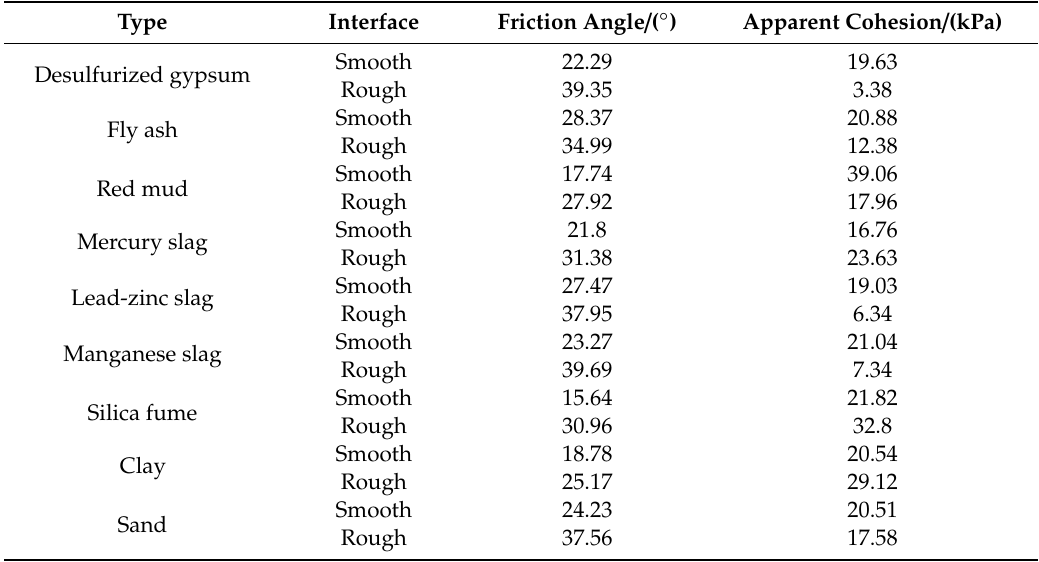
Table 2. Experimental results of direct shear friction characteristics of